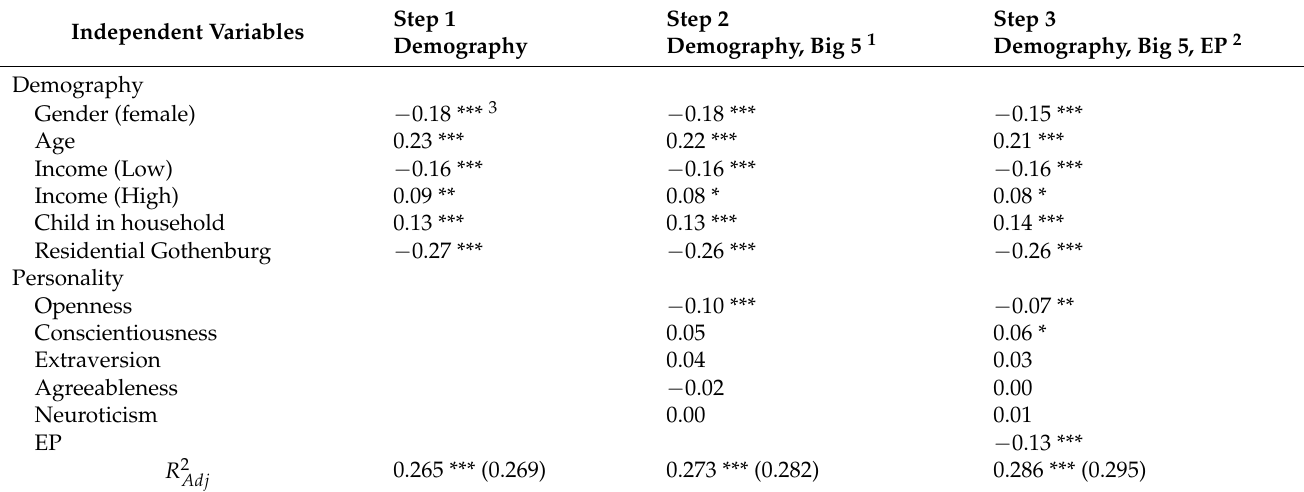
Table 3. Hierarchical regression models exploring how personality predict car driving ( N =